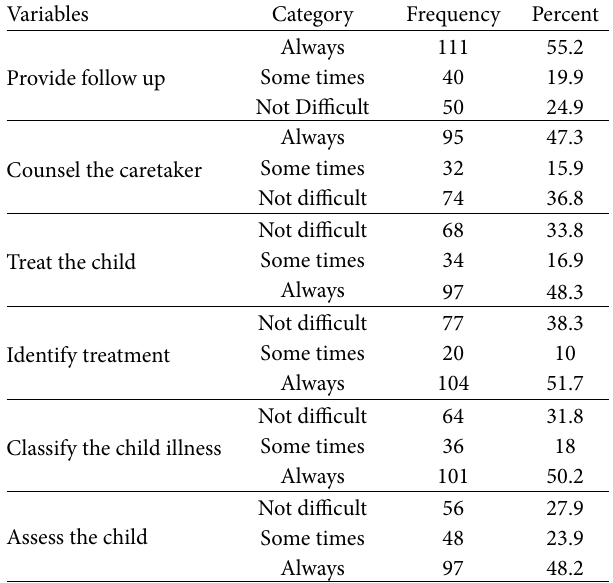
Table 5: Steps in the case management protocol that were found difficult to